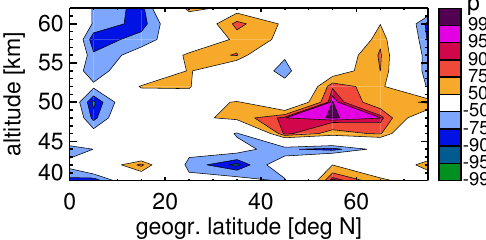
Fig. 4. Correlation coefficient r of the SEA with respect to ∆ Ap (epoch type 2) between ∆ Ap and ∆NO 2 with a delay of one day, plotted over geographic latitudes. Fig. 3. Correlation coefficient r of the SEA with respect to ∆ Ap (epoch type 2) between ∆ Ap and ∆NO 2 , plotted over geomag- netic latitudes with 0/1/2 days delay (top/middle/bottom, respec- tively). Fig. 5. Altitude- and geomagnetic latitude-dependent precision p of the quadrant correlation of ∆ Ly- α and ∆NO 2 . The sign indicates whether the correlation is positive or negative.